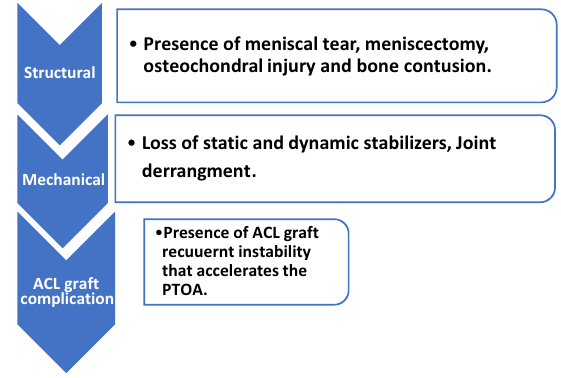
Fig. 11 Demonstrative mechanisms for development of PTOA in ACLR